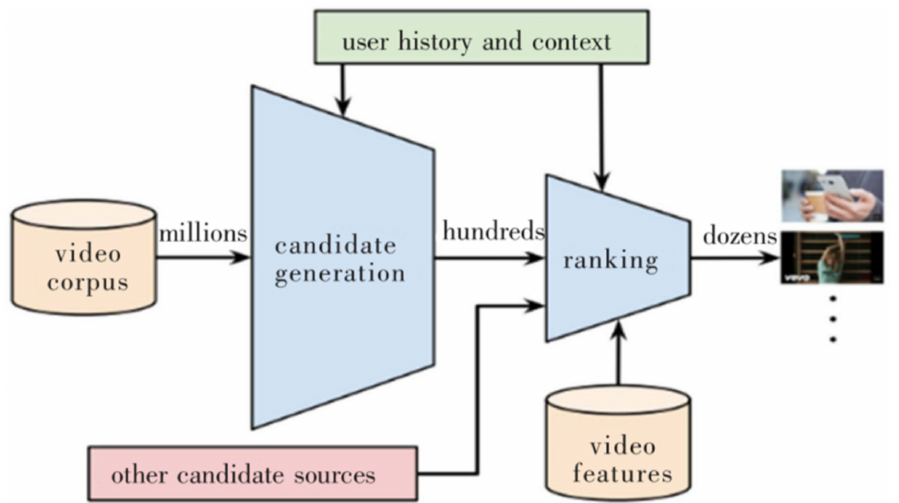
Figure 2. Youtube video recommendation model based on a